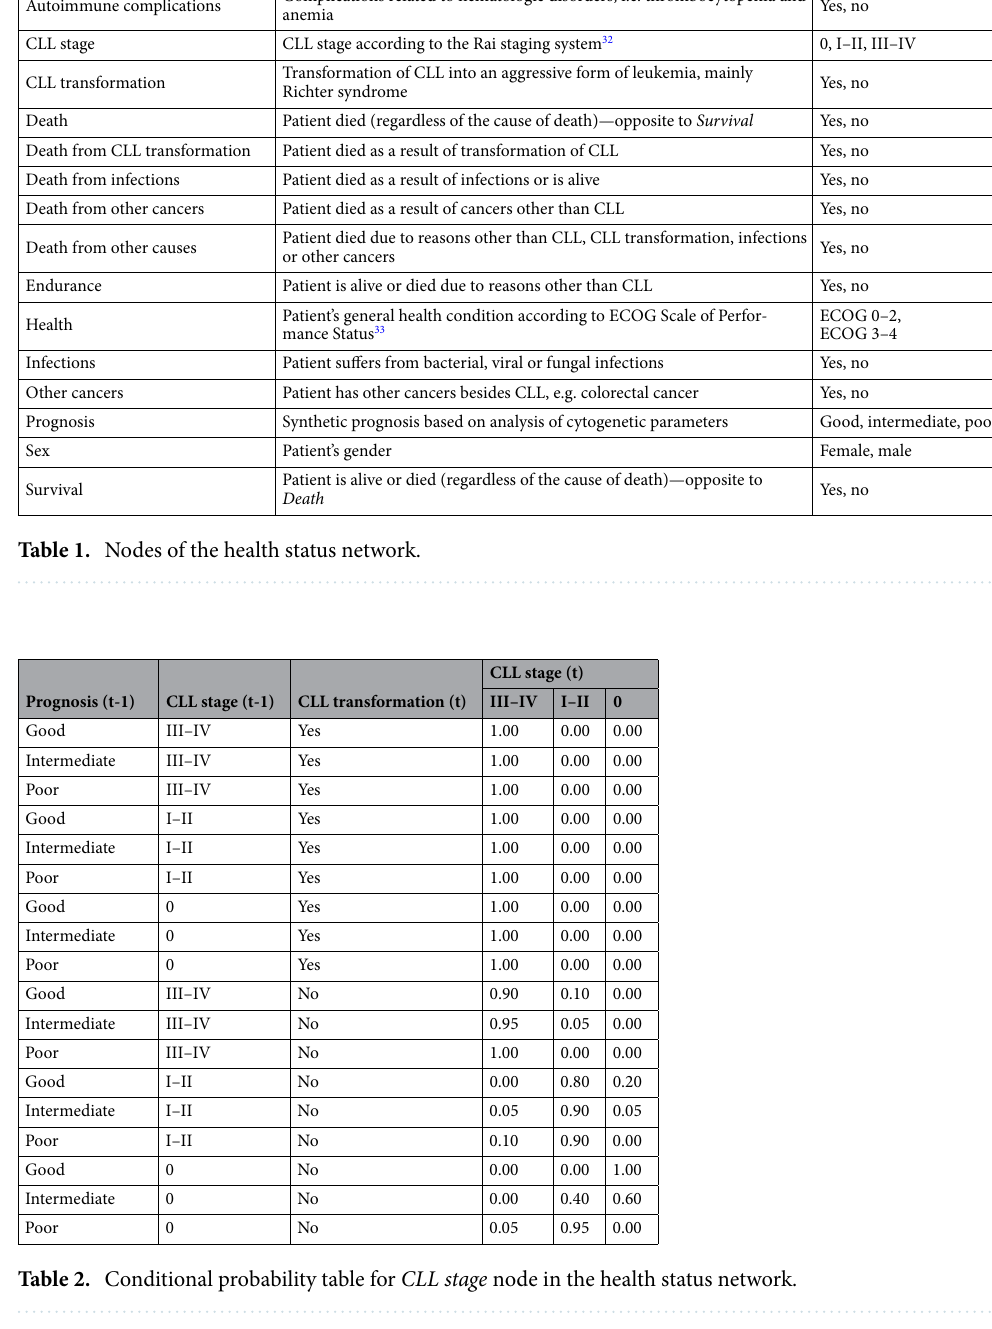
Table 2. Conditional probability table for CLL stage node in the health status network.